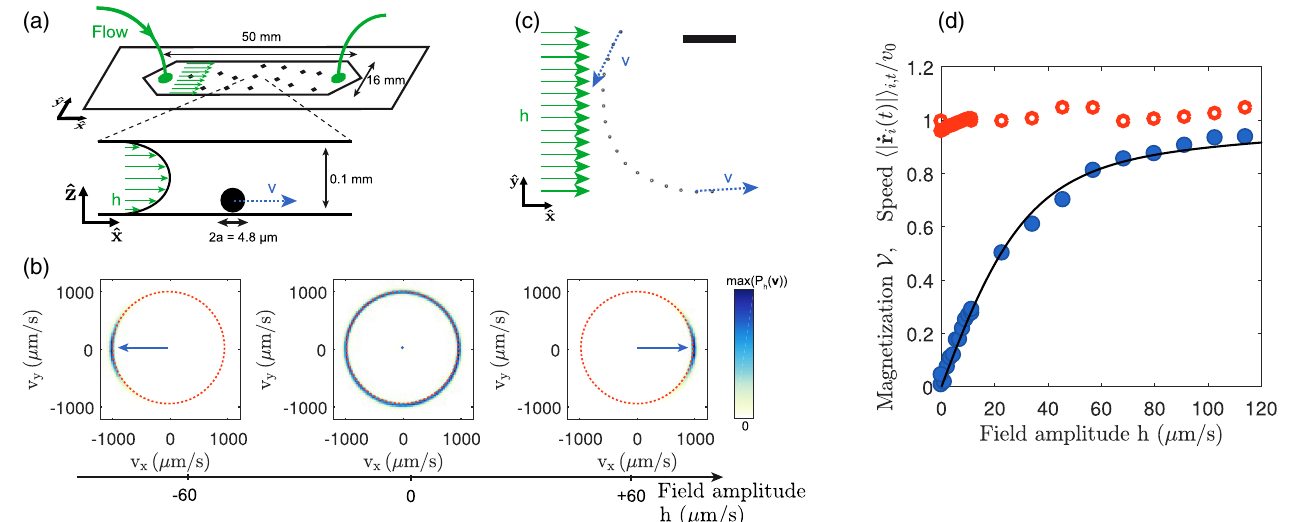
FIG. 1. Isolated colloidal rollers align with external flows as XY spins with magnetic fields. (a) Microfluidic setup. Top: Top view. Bottom: Side view. Colloidal rollers (black dots) of diameter 2 a ¼ 4 . 8 μ m and speed v (blue arrow) are confined in a 50 × 16 × 0 . 1 -mm channel. Hexadecane is injected through the channel at a constant flow rate. A Poiseuille flow results in the ˆ z direction (green arrows). The strength of the external field h is defined as the magnitude of the hexadecane flow at a distance z ¼ a from the bottom wall. ð v Þ . The dashed circles are guidelines (b) Probability density function of the roller velocities for three different hexadecane flows P h corresponding to v ¼ v 0 . When h ¼ 0 , the distribution is isotropic and strongly peaked around v ¼ v 0 . When h ≠ 0 , the distributions are biased along the direction of h , resulting in finite average velocities (blue arrows). (c) Superimposed images of a colloidal roller in a hexadecane flow ( h ¼ þ 60 μ m = s). The time interval between two subsequent pictures is 30 ms. The roller reorients at constant speed along the flow direction. The scale bar represents 100 μ m. (d) Magnetization curve V ð h Þ of the noninteracting rollers (blue circles) and time and ensemble average of the normalized roller speed hj _ r i ð t Þji i;t =v 0 (red open circles). The rotational mobility μ ¼ 0 . 08 μ m − 1 is evaluated from the best fit of the magnetization curve with the theoretical formula (dark solid line), V ¼ I 1 ð μ h=D Þ =I 0 ð μ h=D Þ , where I n is the modified Bessel function of order n